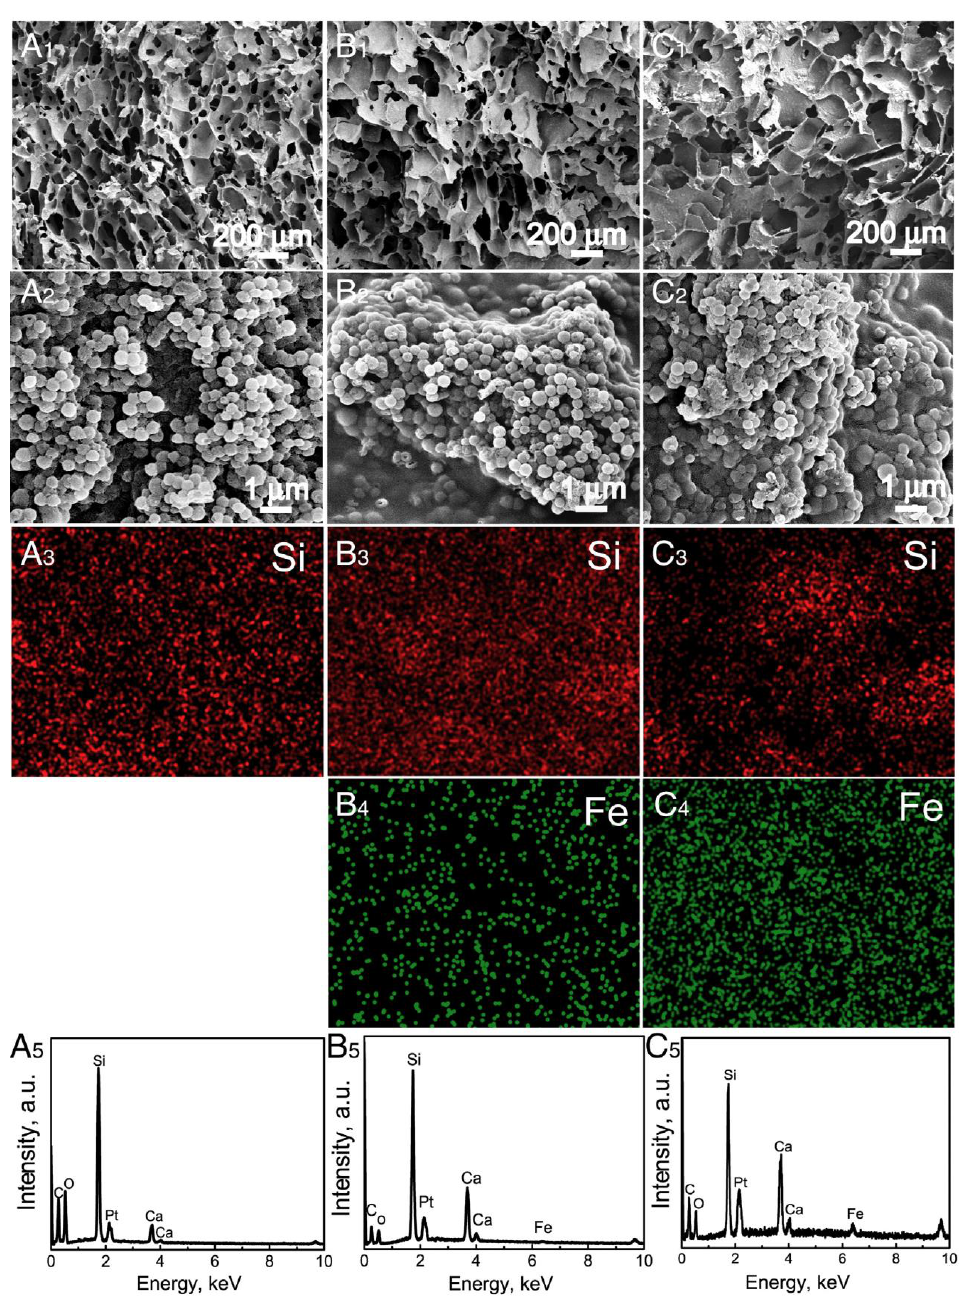
Figure 7. SEM investigation, silicon and iron distribution, and energy-dispersive X-ray spectroscopy for scaffolds prepared using freeze-drying technology: ( A 1 – A 5 ) [CS/MBG] images and ( B 1 – C 5 ) [CS/MBG]/[SrFe 12 O 19 ] images [86]. Reprinted from [86] Copyright (2023), with permission from Elsevier.